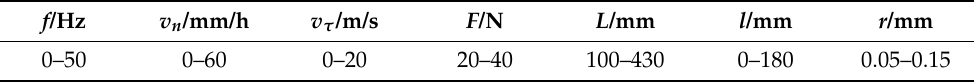
Table 1. Adjustable ranges of experimental